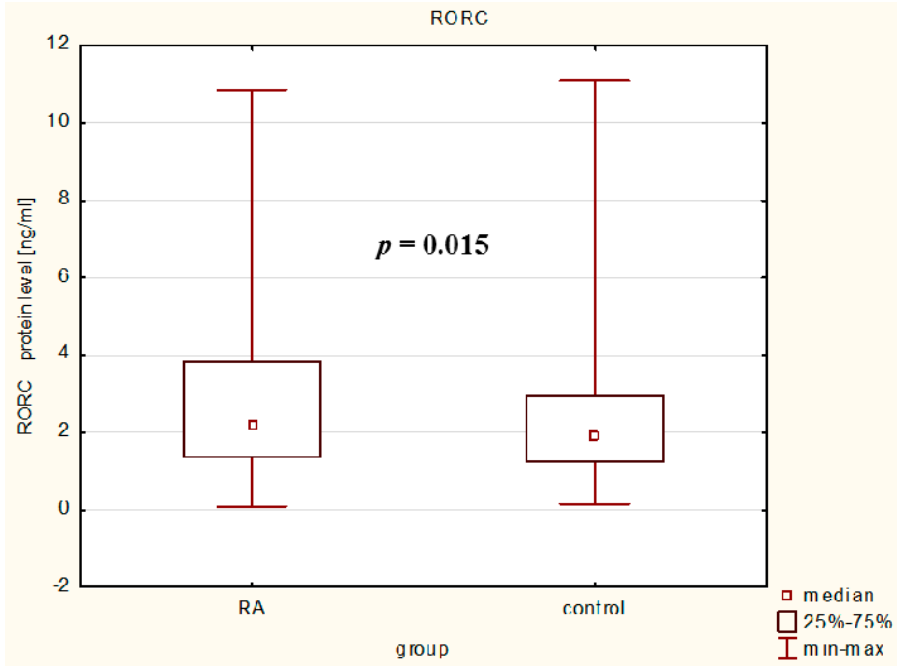
Figure 3. RORc2 protein level in RA patients and healthy subjects. Table 6. The disease activity and laboratory parameters (RA phenotype) in relations to RORc level.